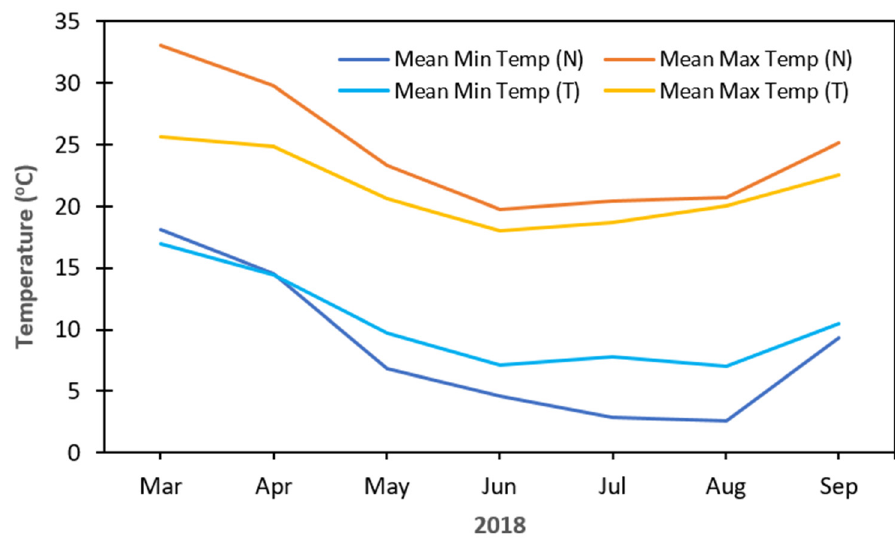
Figure 1. The mean monthly minimum and maximum temperatures (°C) of Narrabri (N), NSW and Toowoomba (T), Queensland sites recorded from the nearest weather station [26].